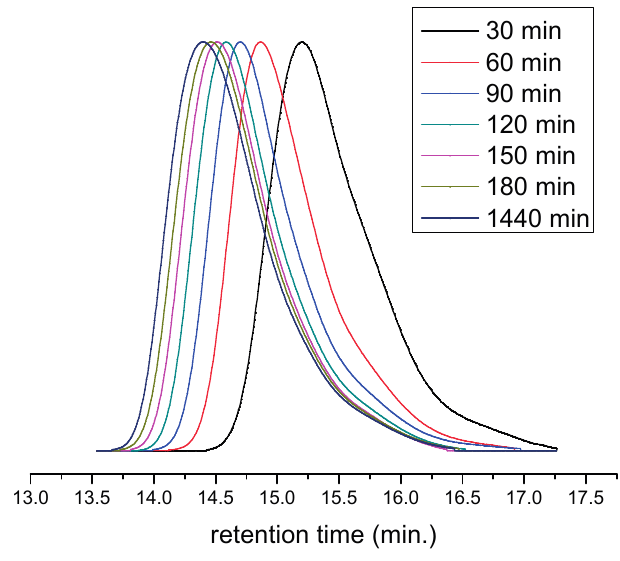
Figure 2. Gel permeation chromatograms (GPC) of the de-grafted polymers (normalized curves) at 30 min intervals and final sample after 24 h.